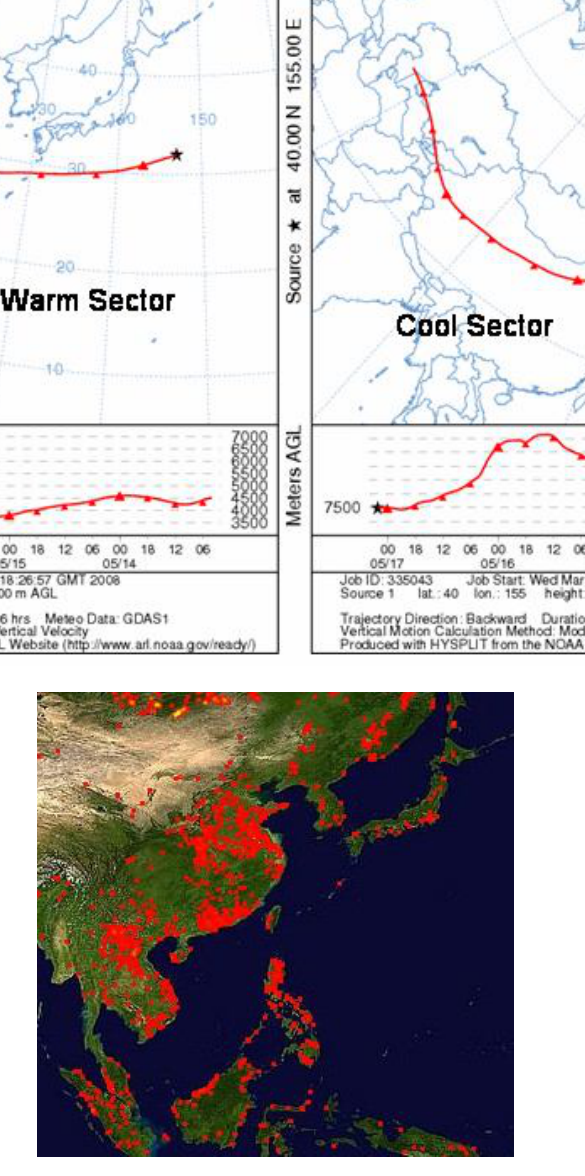
Fig. 3. (Top) NOAA HYSPLIT back trajectories for warm sector air and cool sector air. (Bottom) MODIS fire locations for 11 May through 20 May 2010, (credit: NASA/GSFC, MODIS Rapid